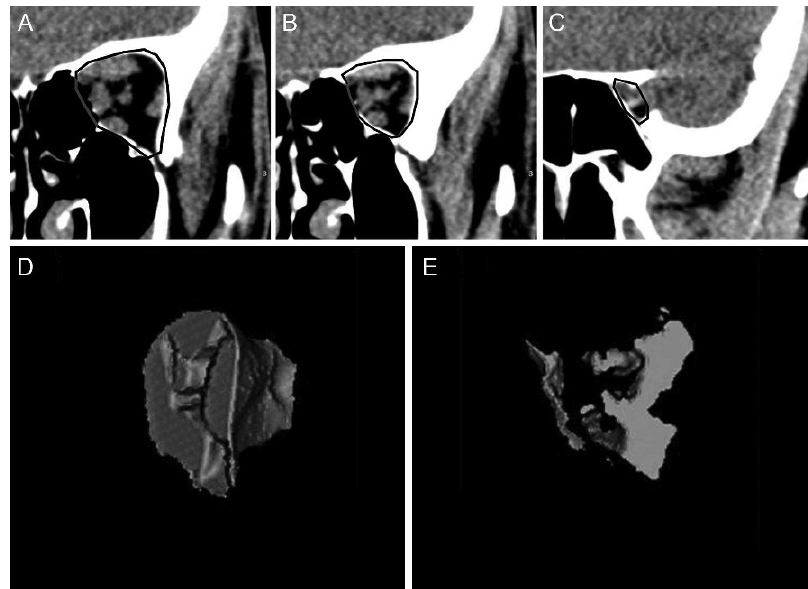
Figure 3 - A, B and C. Examples of the area outlined on 3 coronal slices of computed tomography scans, from which measurements were obtained. Representation of the soft tissue (mostly muscles) (D) and orbital fat (E) apical volumes based on sequential coronal